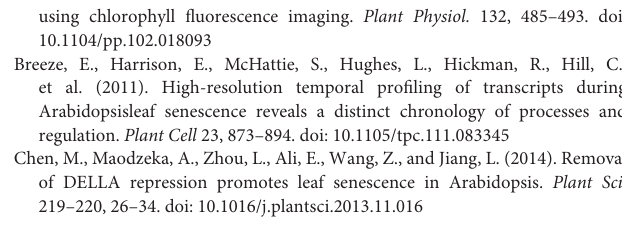
Table S1 | List of primers used in this study. Table S2 | Complementation tests of Arabidopsis eas1 and aba mutants. Figure S1 | EAS1 mutation accelerates plant senescence and flowering under unstressed conditions. (A) Comparison of flowering phenotype from 40-day-old wild-type and OE-EAS1 and eas1 mutant plants grown under unstressed conditions in soil. (B) Thirty-five-day-old wild-type (Col-0 background) and aba2-1 (Col-0 background) mutant plants grown under unstressed conditions. (C) Seedlings of wild-type and OE-EAS1 and eas1 mutant plants grown for 30 days on agar plate in unstressed growth conditions. eas1-1 and eas1-2 mutant plants show the senescence phenotype of yellowing leaves. Figure S2 | The eas1 mutants are two new aba2 alleles. (A) Positional cloning of EAS1 . EAS1 was mapped to chromosome 1 between BAC clones F9I5 and F6D8. The eas1-1 and eas1-2 mutations were generated in the second exon in the ABA2 gene (At1g52340). Closed boxes represent the open reading frame. The red dot is the centromere of chromosome 1. (B) ABA content of the fifth rosette leaf of wild-type and mutant plants at day 25 after sowing under unstressed condition in soil. (C) Germination of eas1-1 and eas1-2 mutant seed is apparently insensitive to salt and mannitol treatment at different concentrations compared with wild-type seed. Seeds were germinated on agar medium supplemented with different concentration of NaCl or mannitol.The data collection were performed at day 5 after germination. (D) Infrared image of wild-type and eas1-1 and eas1-2 mutant plants at day 25 after sowing under unstressed conditions in soil. (F) Rate of water loss of detached leaves of wild-type and eas1-1 and eas1-2 mutant plants. Three experiments were performed with similar results. Error bars indicate standard deviations, while asterisks indicate significant differences from wild-type plants under Student’s test (** p < 0.01 ). Figure S3 | Determination of viability of wild-type and eas1 - 1 mutant protoplasts in an age-dependent manner. (A,B) Estimation of mesophyll protoplast activity by FDA staining. Bars indicate standard errors, while asterisks indicate significant differences from wild-type plants (* p < 0.05 , ** p < 0.01 ); three experiments were performed with similar results. (C) Total protein extracted from the same weight of fresh leaf of the first to sixth true leaves of wild-type